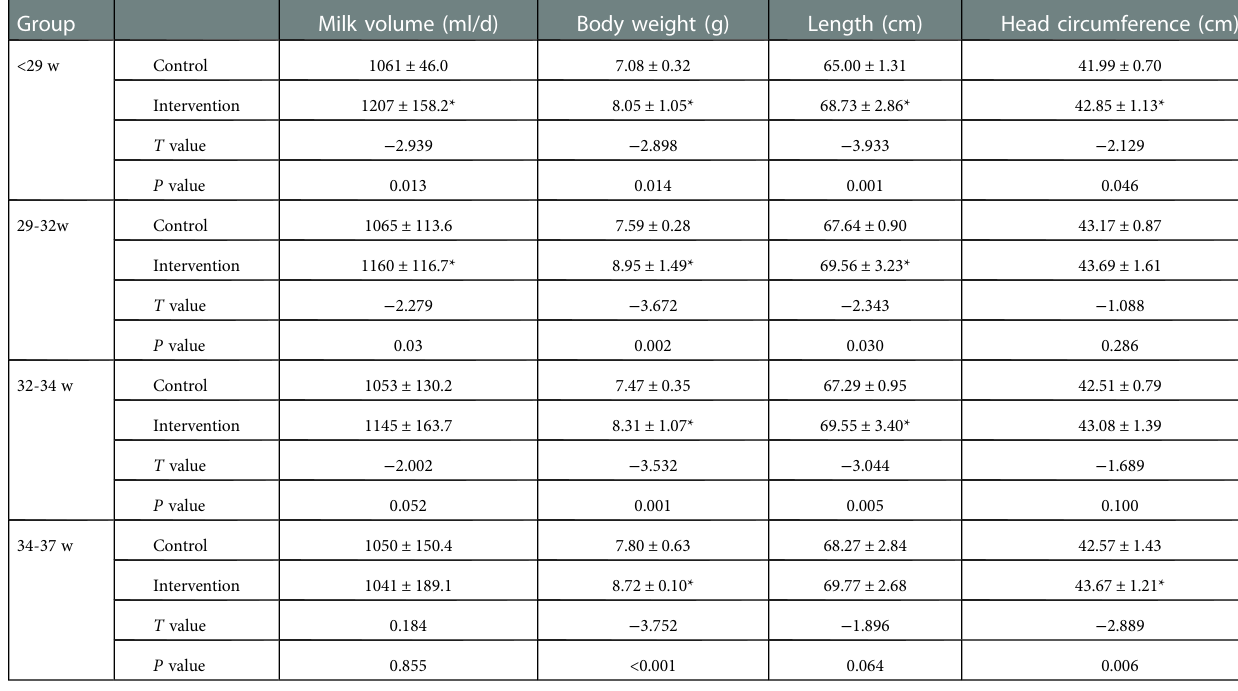
TABLE 5 Comparison of physical development of preterm infants with different gestational ages at 6 months corrected age. Group Milk volume (ml/d)